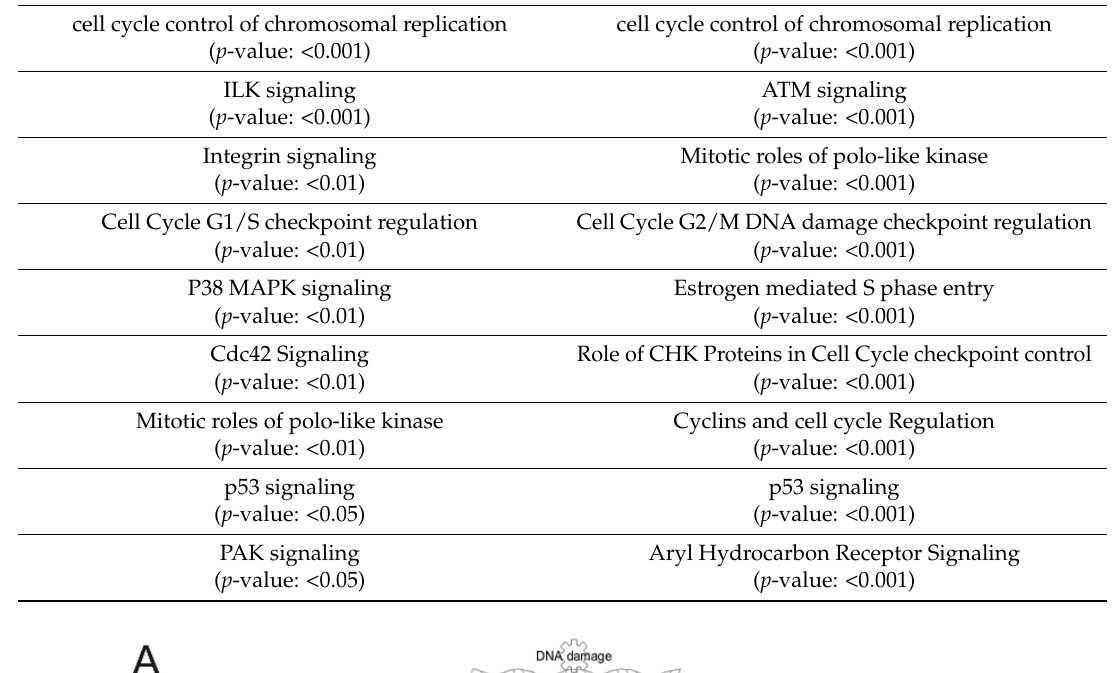
Table 3. List of Enriched Canonical Pathways from genes commonly shared among wildtype cells and emerin-null cells during key differentiation transitions using Ingenuity Pathway Analysis. Canonical Pathway Identified for Genes Common Canonical Pathway Identified for Genes Common between Wildtype and Emerin-Null Cells during between Wildtype and Emerin-Null Cells during Transition from Day 1 to Day 2 of Differentiation Transition from Day 0 to Day 1 of Differentiation cell cycle control of chromosomal replication